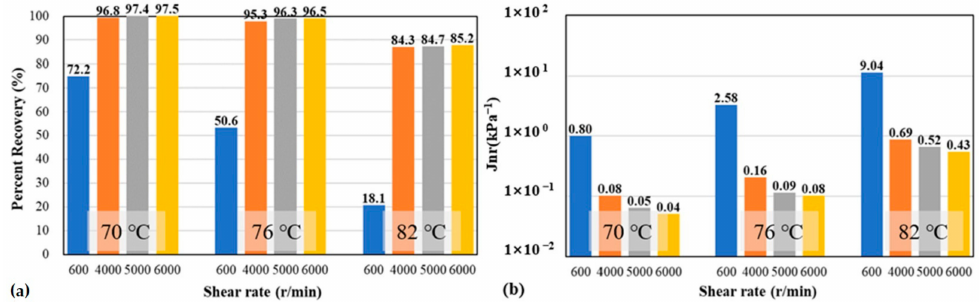
Figure 4. MSCR test results of SBS-modified asphalt under different shear rates ( a ) R, ( b )